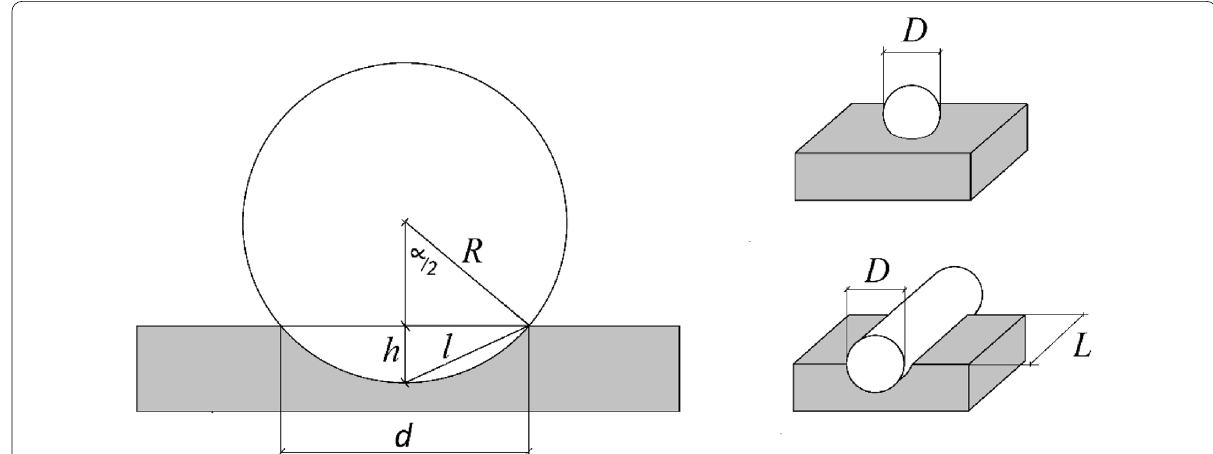
Fig. 1 Diagram of geometrical parameters of indentations in wood exerted by spherical (Brinell, Janka, Krippel and Meyer tests) and cylindrical (Monnin test)